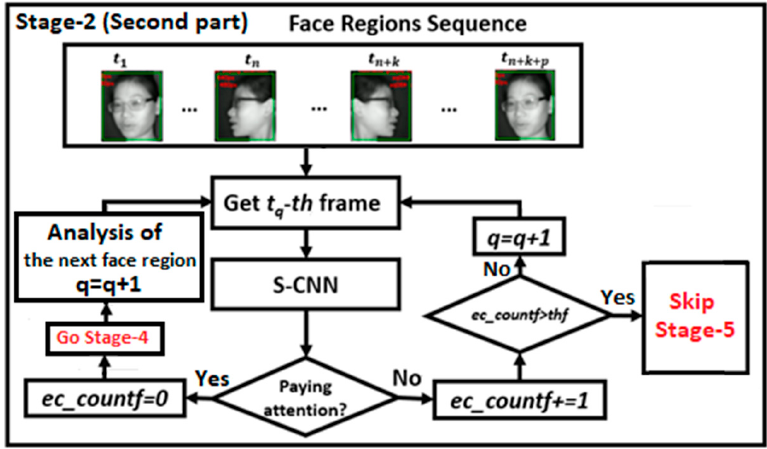
Figure 6. Distraction detection by classification.